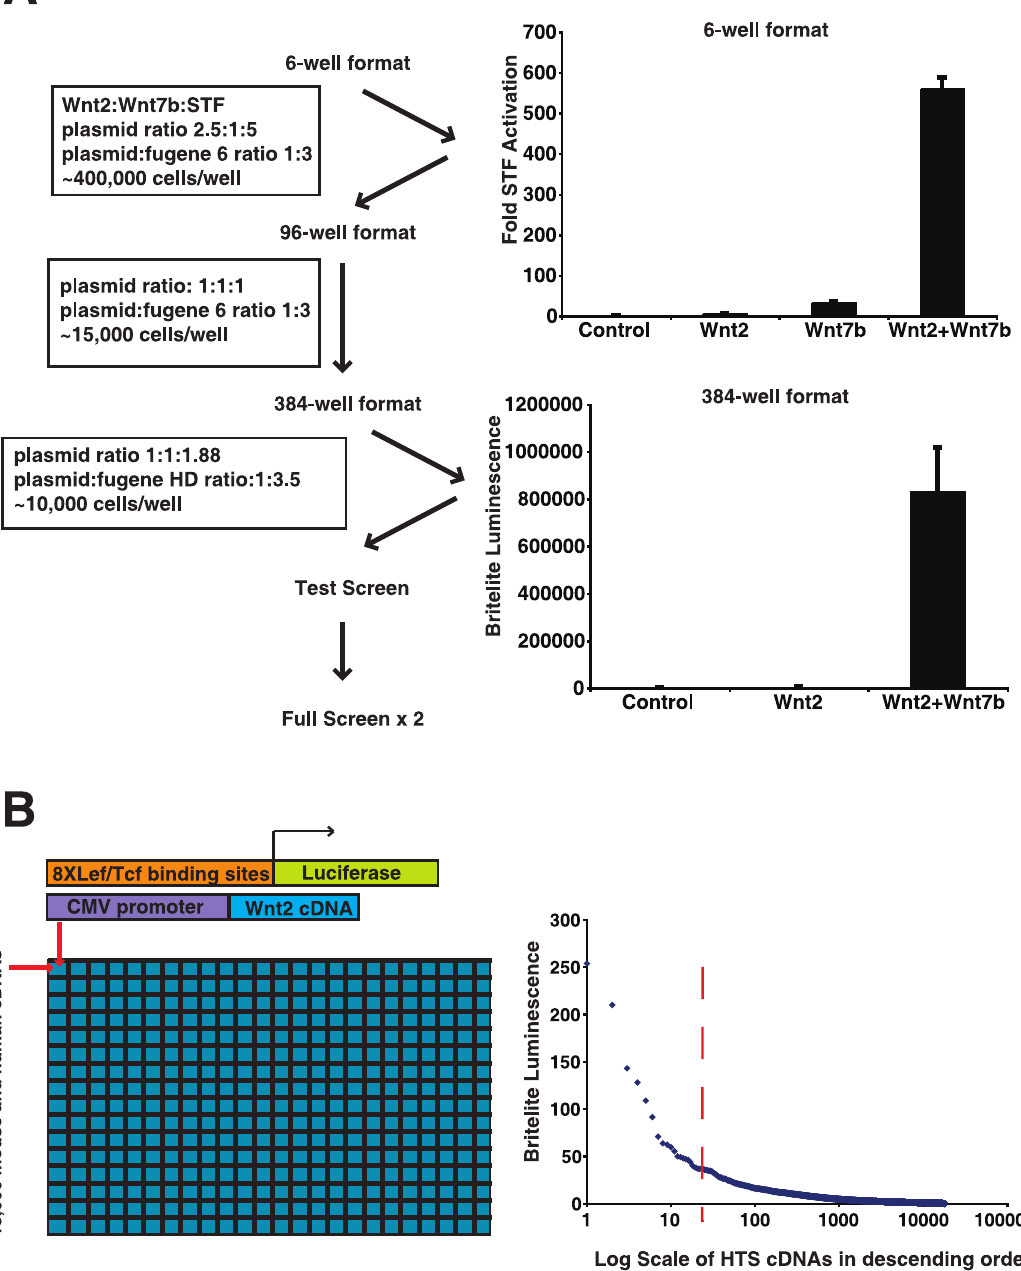
Figure 1. High throughput genomic screen for identification of factors cooperating with Wnt2 signaling activity. (A) The standard 6- well assay was first optimized for 96-well format and then for the high throughput 384-well format. (B) Diagram of how the 384-well HTS screen was performed. Our cutoff was at 35-fold higher than the median of each plate. Each 384-well plate contained internal positive and negative controls.